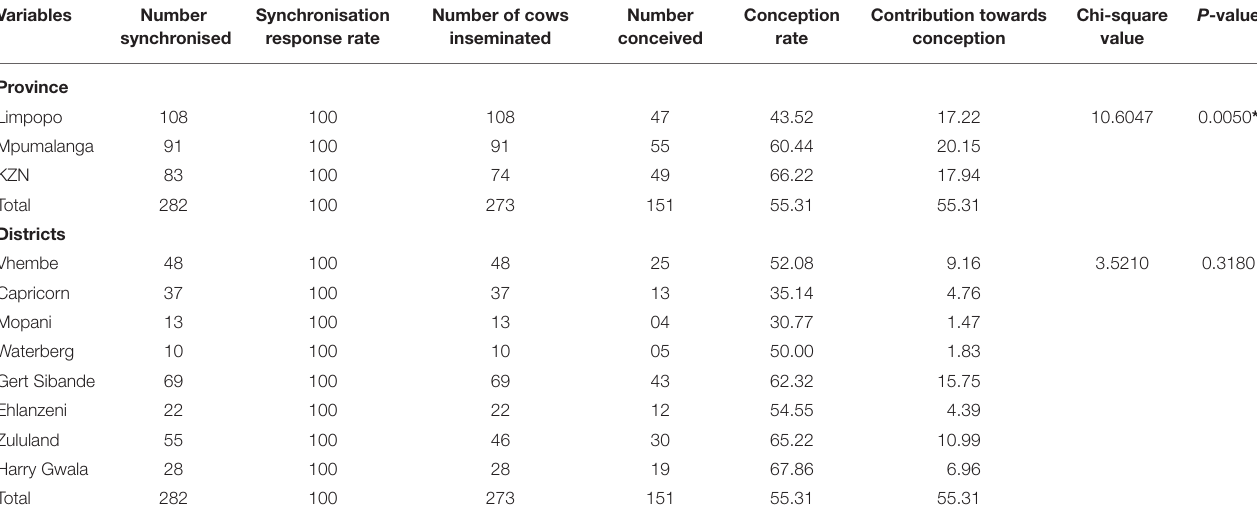
TABLE 1 | Effect of province and districts on synchronisation response and conception rate of cows under communal and emerging farming systems.